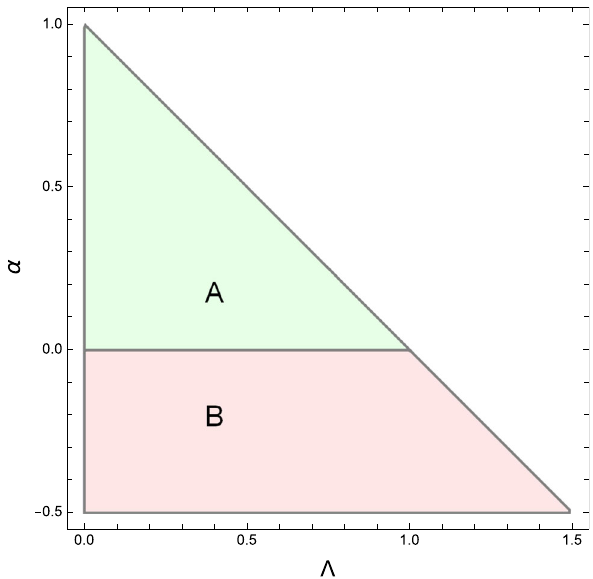
Fig. 1 The parameter region where both the event horizon and cosmo- logical horizon exist. The region is bounded by α > − 0 . 5, (cid:3) > 0 and α + (cid:3) < 1. The metric function is real for all r > 0 in region A , while becomes complex for small r in region